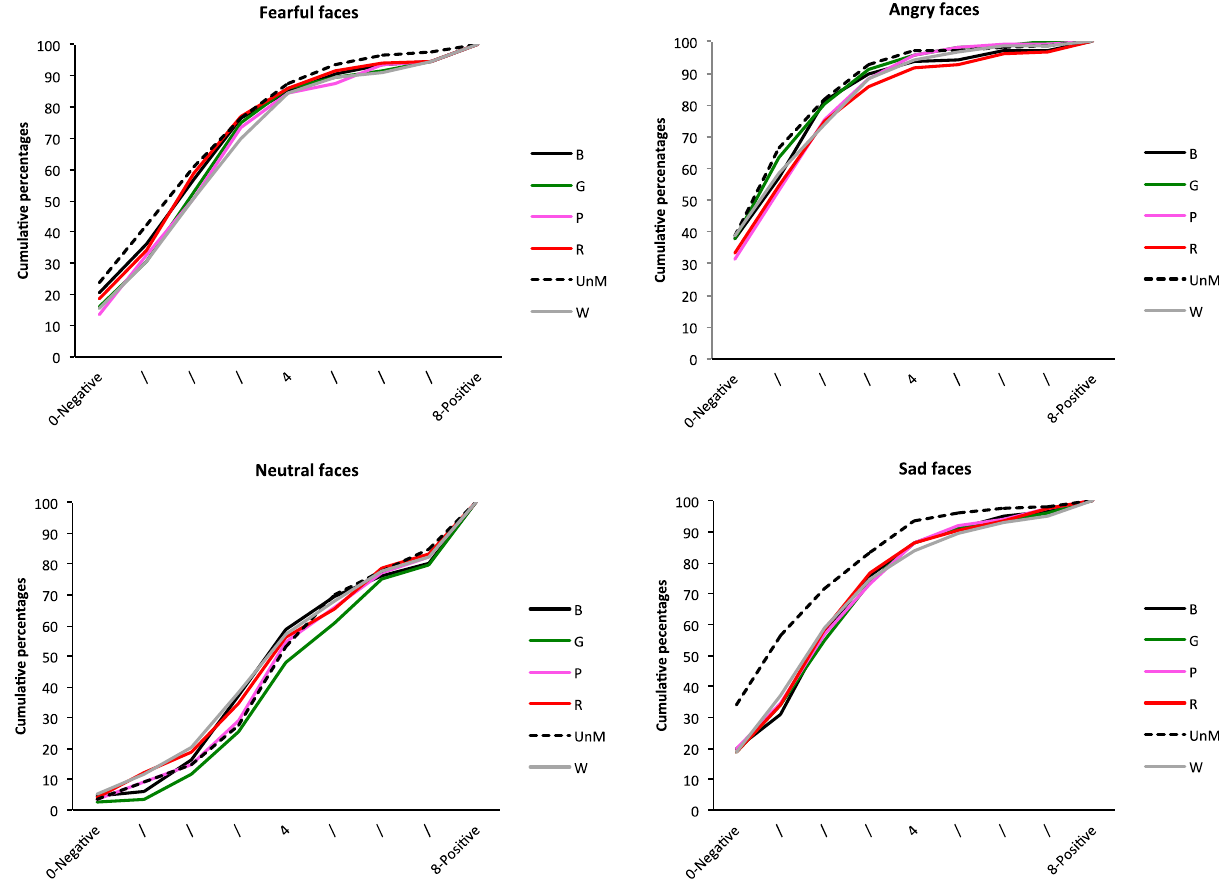
Figure 9. Cumulative percentages of the perception of each EFE for Scale 4, as a function of mask condition (faces wearing a B black, G green, P pink, R red, W white, mask ; UnM unmasked